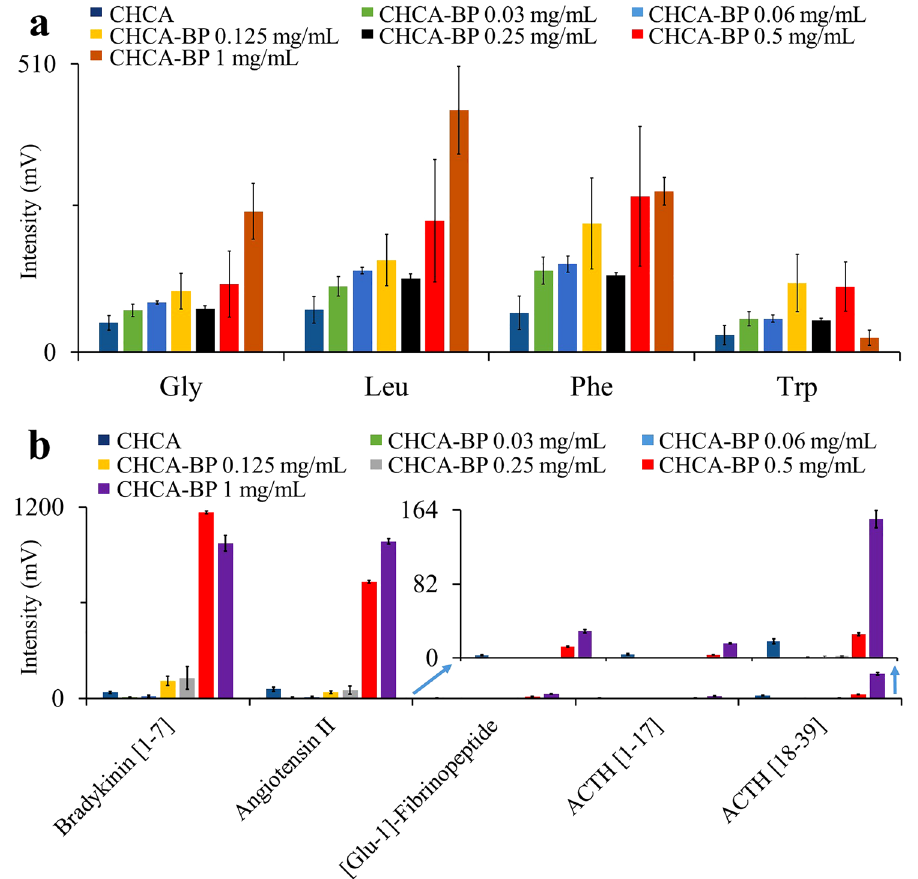
Figure 4. Effect of BP on peak intensity is dose dependent. Matrix solution containing α-cyano-4- hydroxycinnamic acid (CHCA) was supplement with increasing concentration of BP as indicated. ( a ) amino acids, ( b ) peptides. Mass spectra were recorded in positive ion mode with laser energy 70 a.u. for amino acids and 110 a.u. for peptides, respectively. 100 spectral profiles were recorded. Columns show means ± Std. errors of three independent